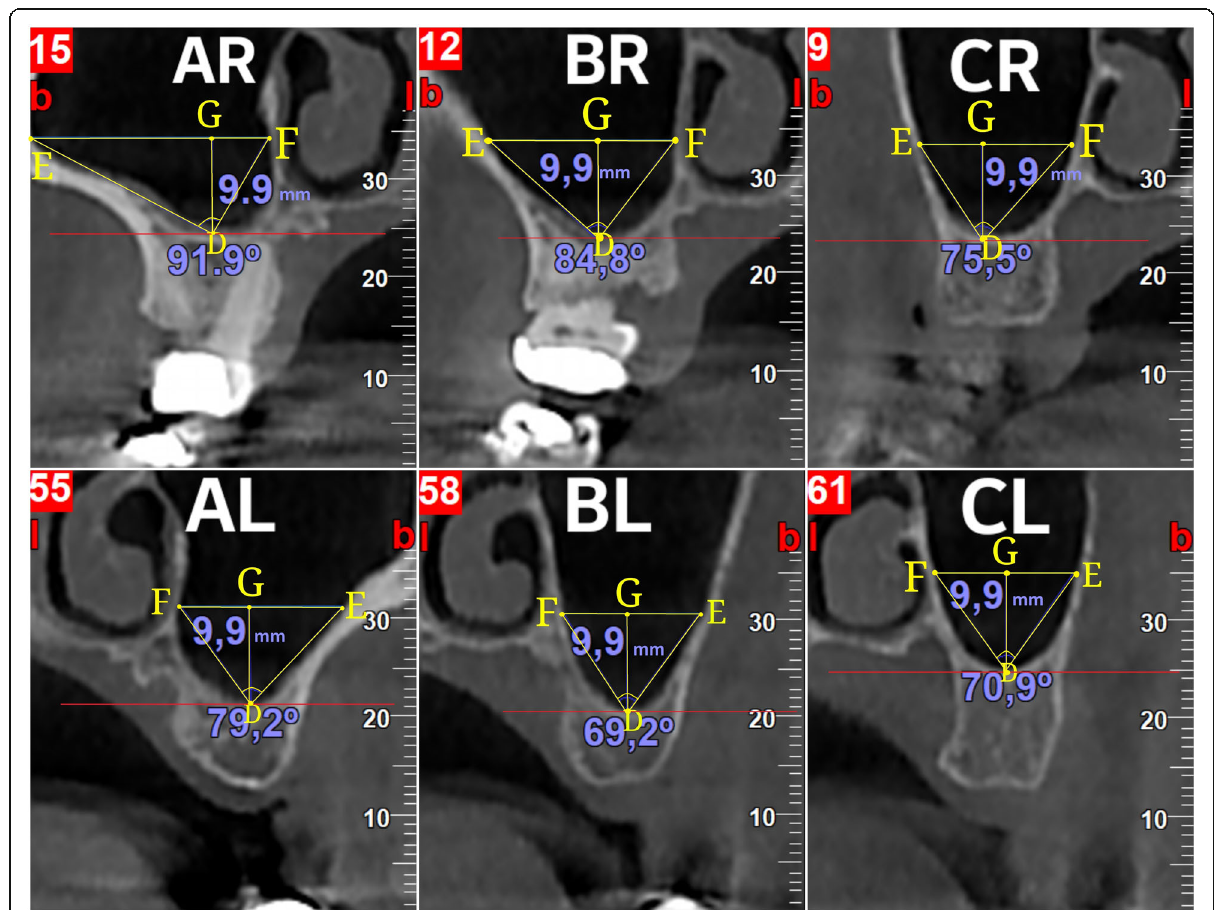
Fig. 3 Demonstration of the method used to measure the angle designated by the buccal and lingual walls of the sinus angle for each of the three fixed points in a given height